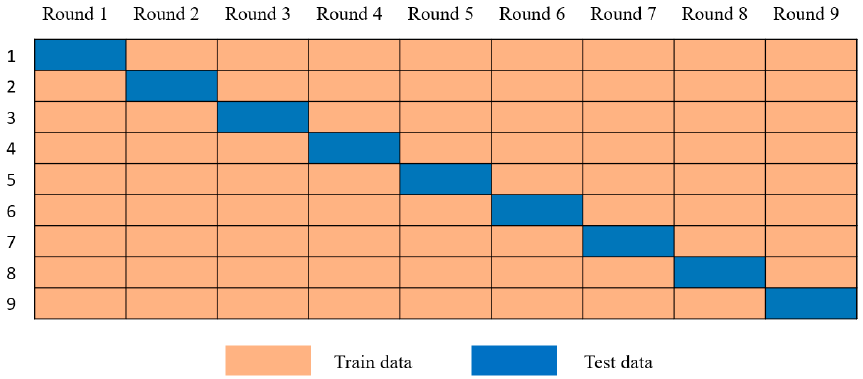
Figure 4. Conceptual representation of leave-one-out procedure.